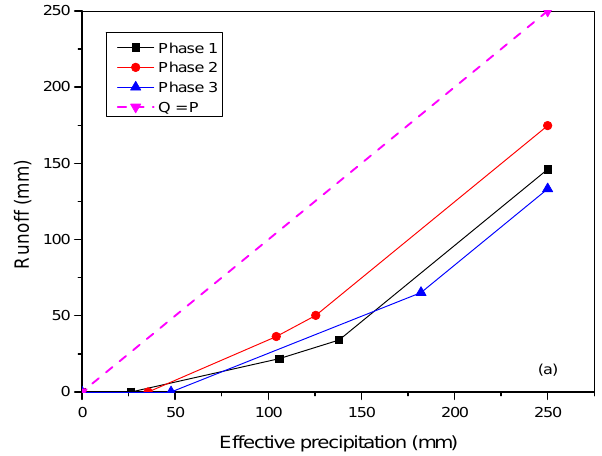
Figure 3. The effective precipitation-runoff relationship for the AWBM model (Phase 1: August 1970–July 1990; Phase 2: Au- gust 1990–July 1994; Phase 3: August 1994–July 2006).